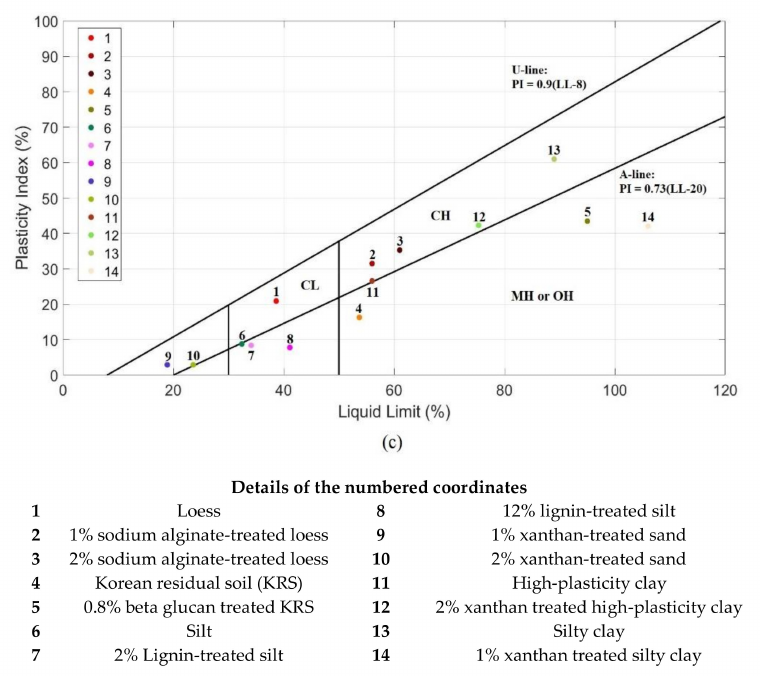
Figure 10. Variation of Atterberg limits by adding biopolymer, ( a ) liquid limit, ( b ) plasticity index, ( c ) plasticity chart